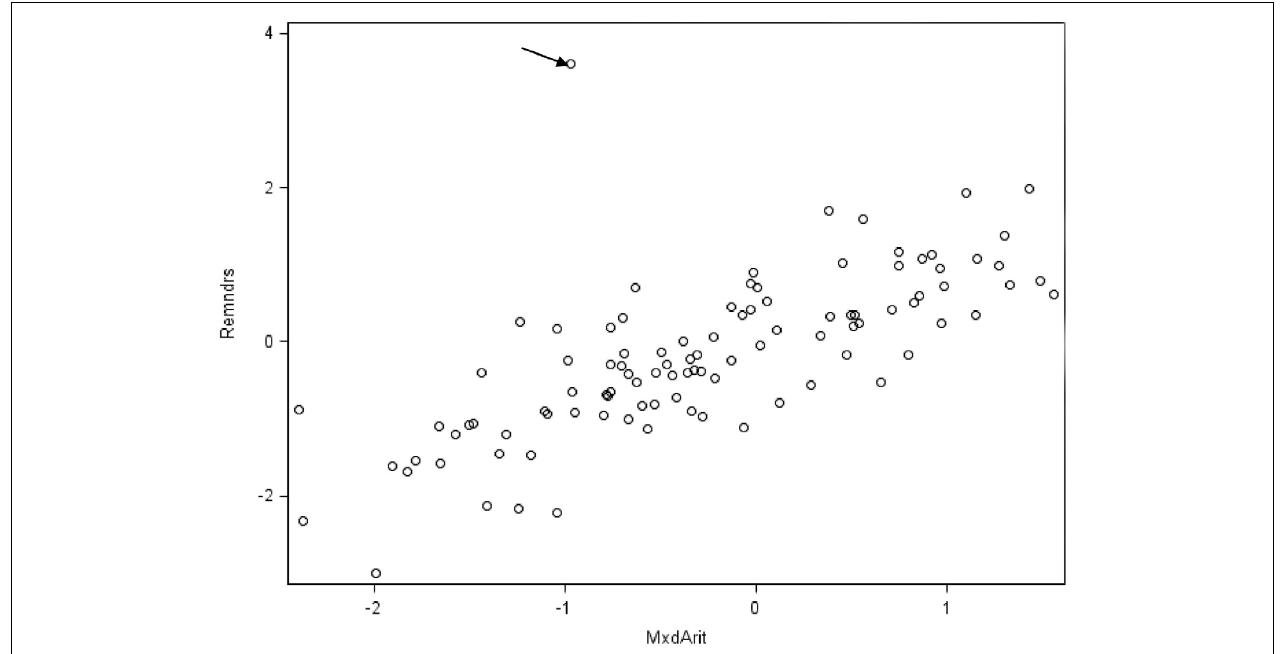
FIGURE 5 | Scatterplot of “Remainders” by “MixedArithmetic” for perturbed sample with influential case indicated.